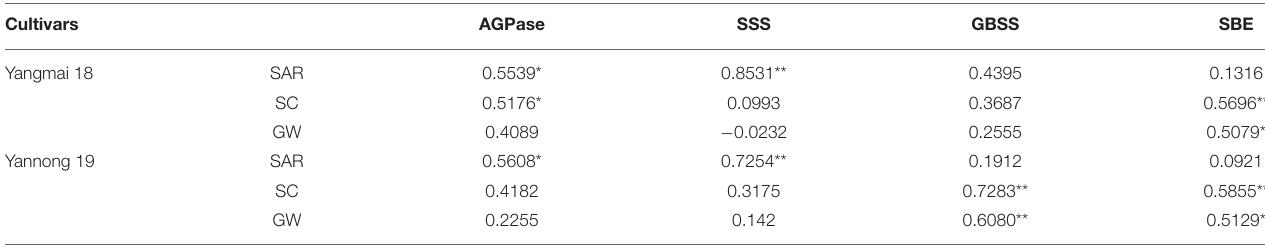
TABLE 3 | Summary of the correlation coefficients between the rate of starch accumulation, the starch content, the 1000-grain weight, and the enzyme activities after LT stress at booting stage. Cultivars